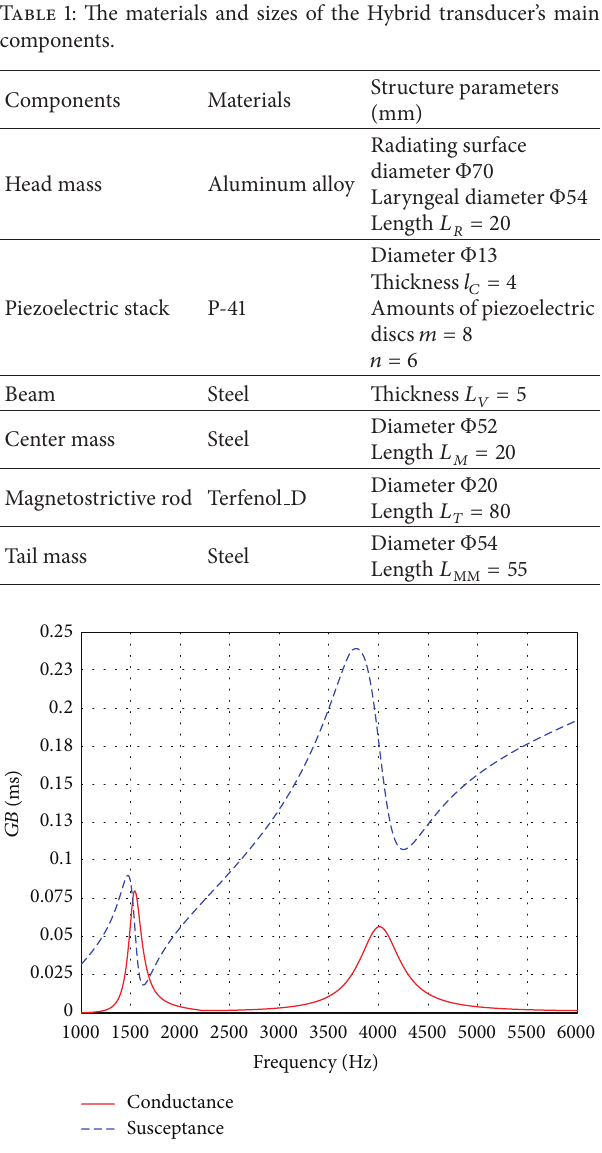
Figure 3: Admittance curves when only voltage drives in piezoelec- tric section (in water, obtained from equivalent circuit